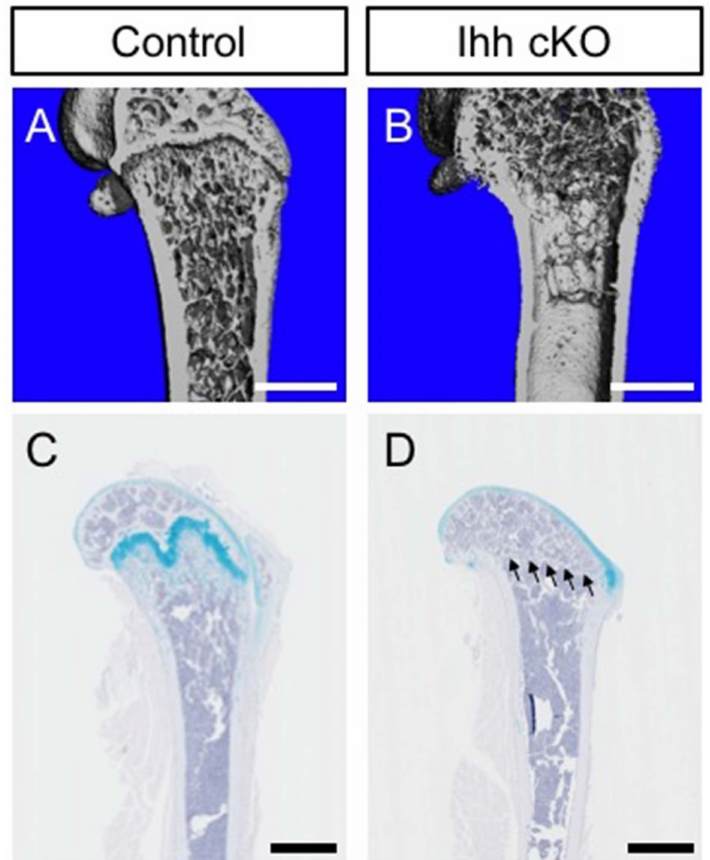
Figure 3. Chondrocyte-derived Ihh is required for the maintenance of a normal growth plate. ( A , B ) Longitudinal view of µ CT images in distal femur from control and Gli1-CreER; Ihh c / c (Ihh cKO). Control and Ihh cKO littermate mice were treated with tamoxifen at four weeks of age and analyzed after eight weeks to inactivate the Ihh gene. Note decreased trabecular mass and completely lacked growth plate in Ihh cKO mice ( B ). ( C , D ) Representative images of femur stained with hematoxylin and alcian blue. Alcian blue positive cartilage matrix in the distal femur is absent in Ihh cKO mice (D, arrowheads show). Scale bars indicate 1 mm ( A , B ) and 1.25 mm ( C , D